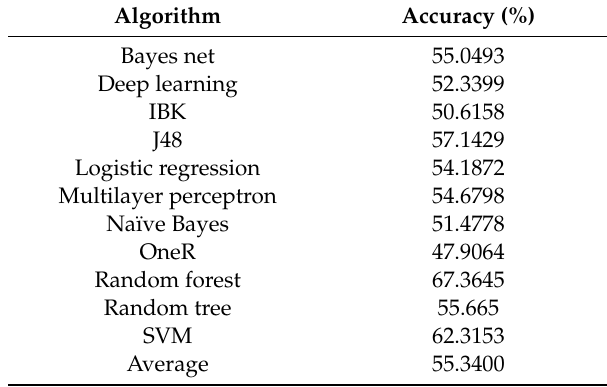
Table 1. Accuracy from 11 ML algorithms classifying data into four